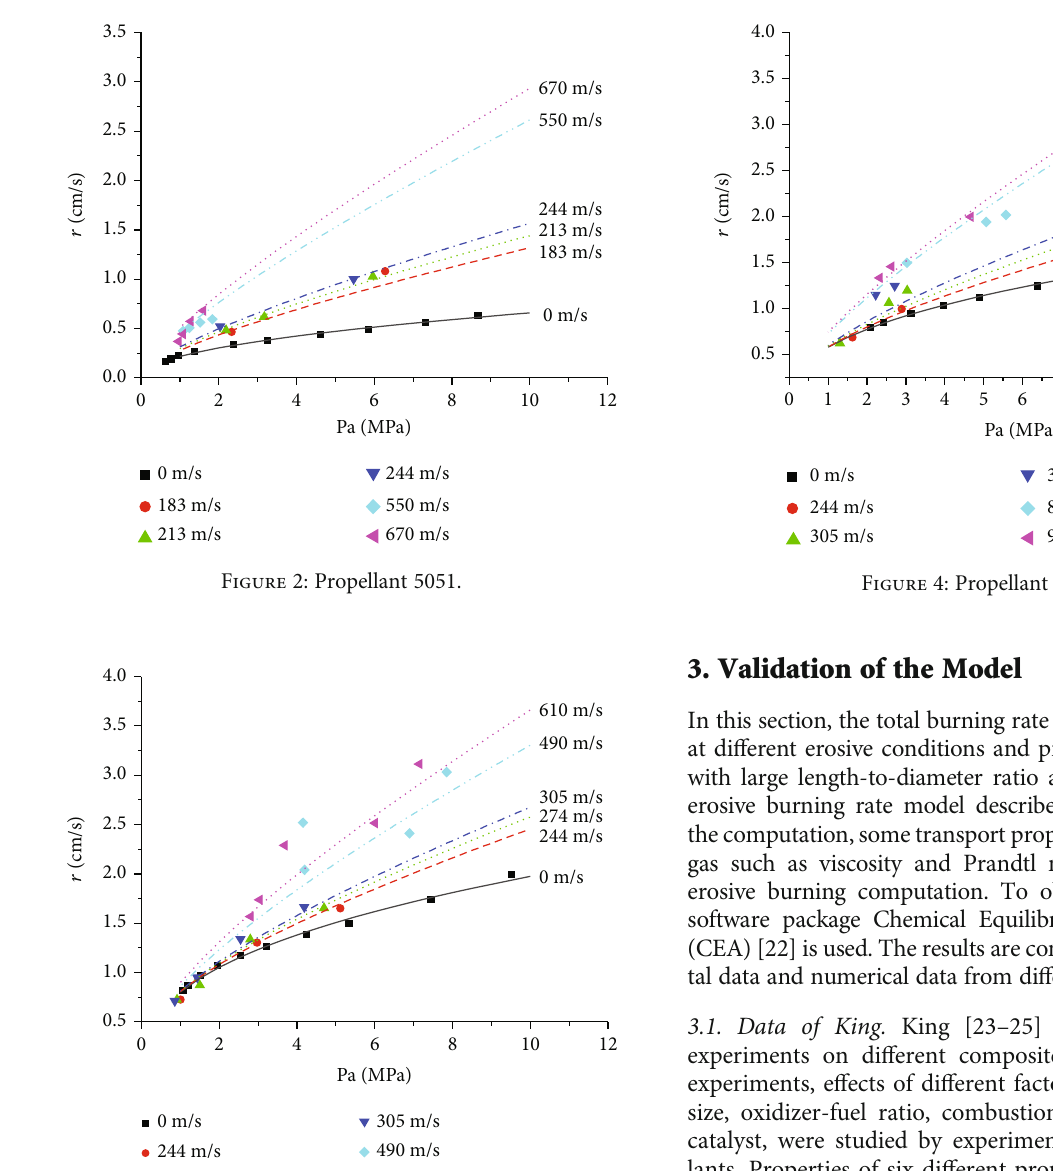
Figure 3: Propellant 4869.